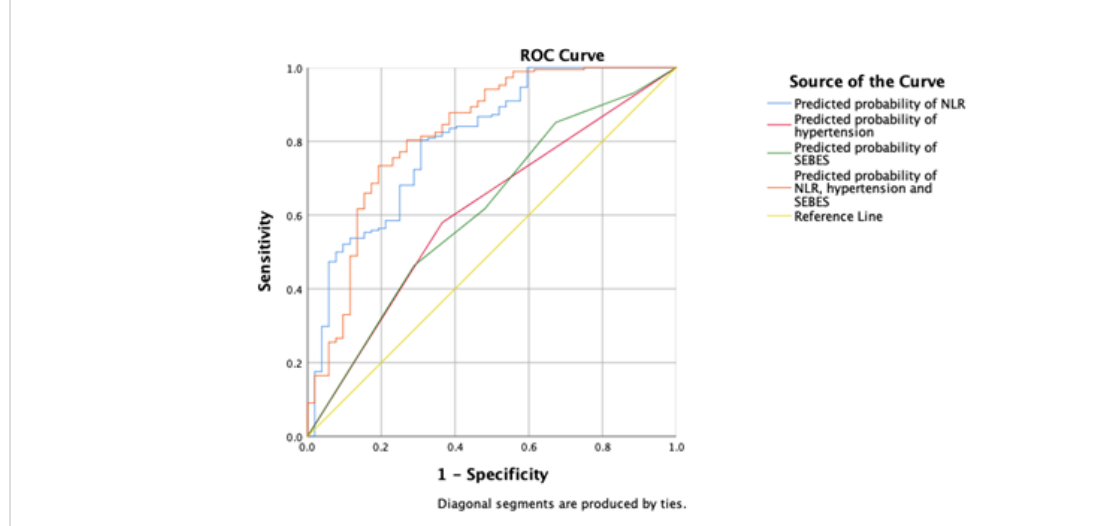
FIGURE 2 ROC analysis of the correlation between NLR and mRS at 3 months.